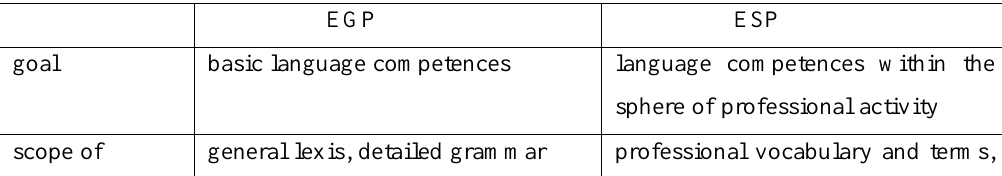
Table 1. EGP vs ESP